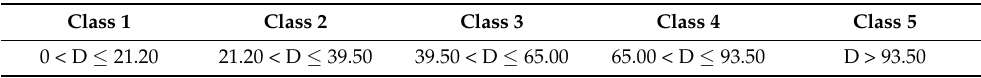
Table 2. MWD of different soil block sizes obtained by standard mechanical sieve.